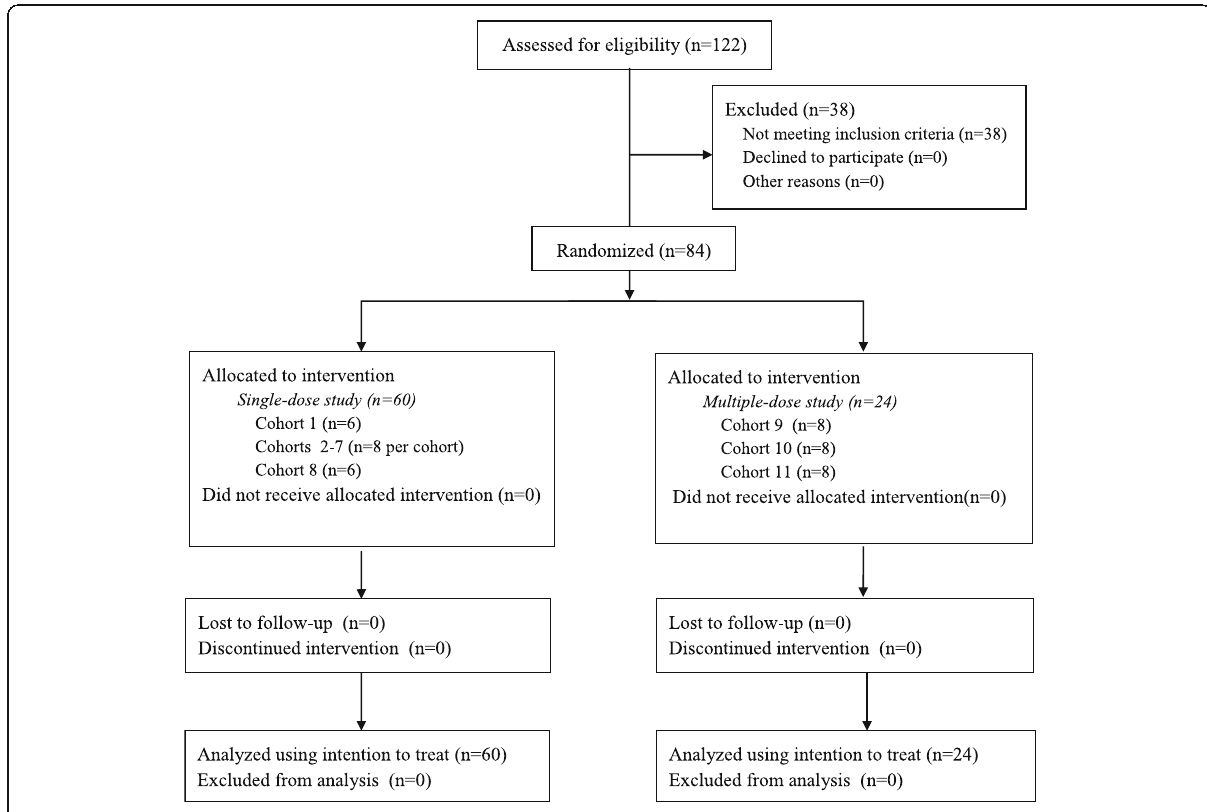
Fig. 1 Flowchart of the study